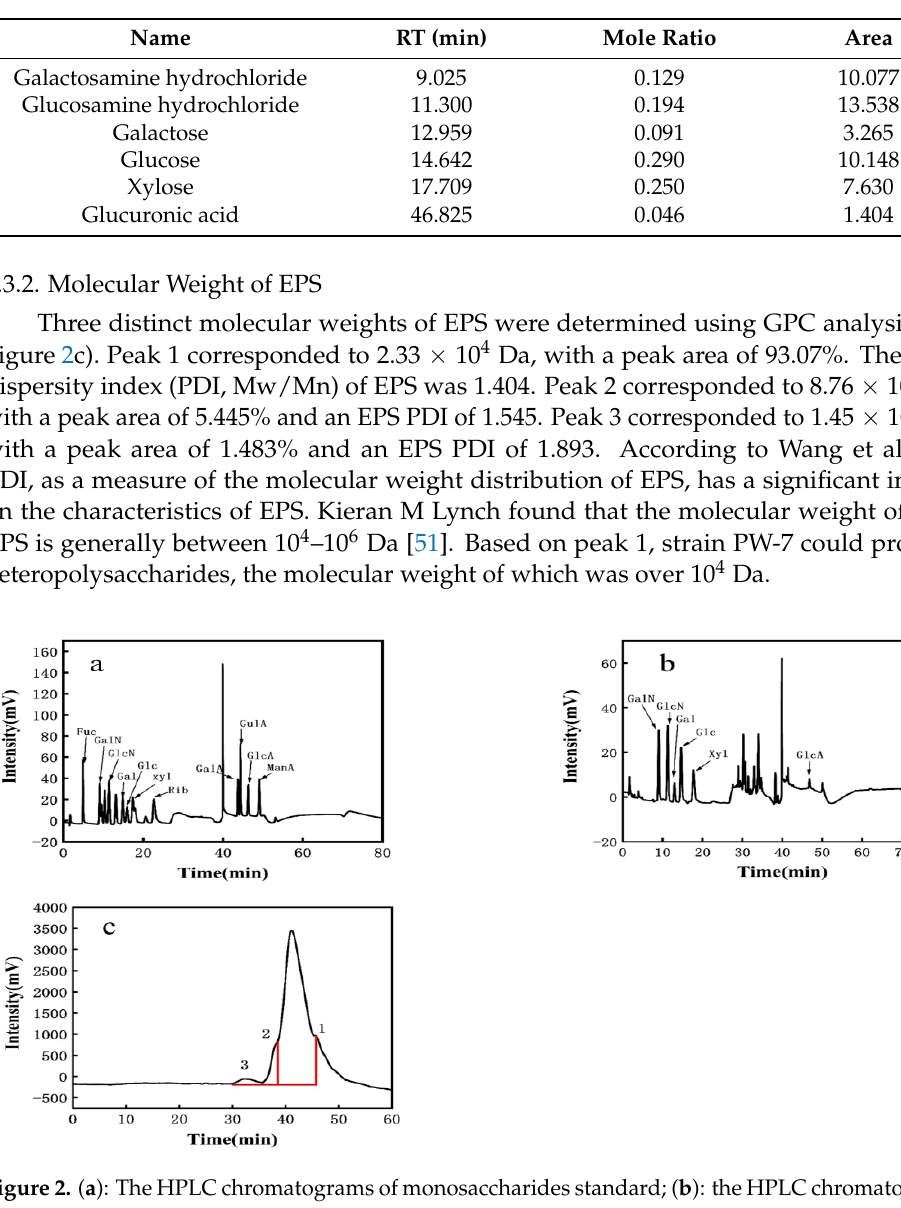
Table 3. MIC of EPS against indicator